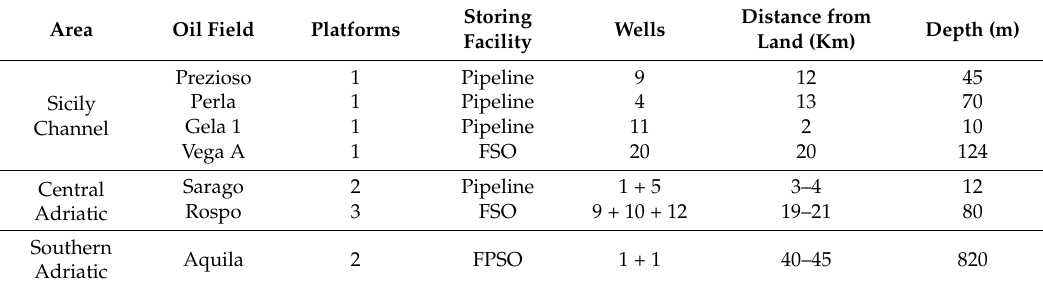
Table 1. The oil fields in the Italian seas covered by the forecasting system (data from the Italian Ministry for the Economic Development—MISE [18], updated on 31 December